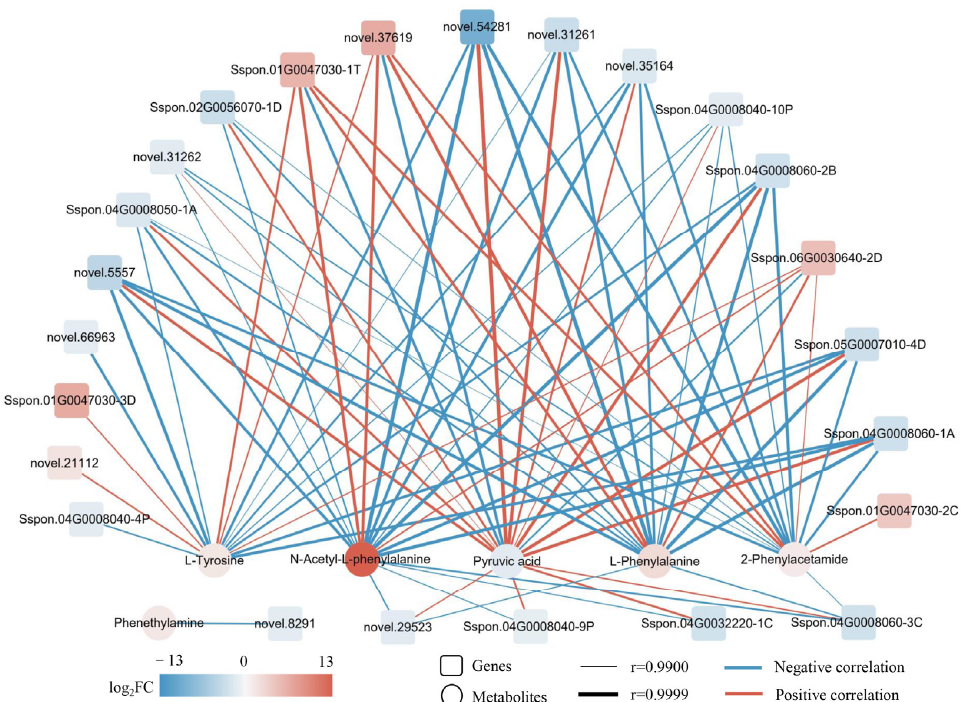
Figure 9. Correlation network of DEGs and SRMs in the phenylalanine metabolism pathway. The genes and metabolites color-coded according to fold-change between the CG and DS groups. |log 2 FC| denotes |log 2 Fold Change|.